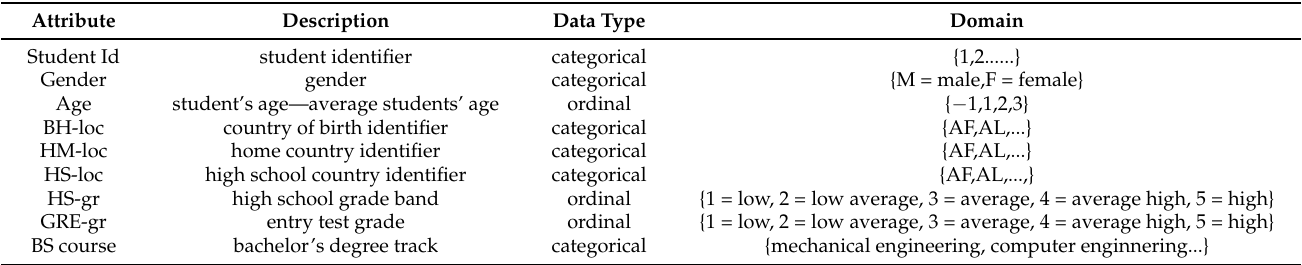
Table 3. Schema of the Students